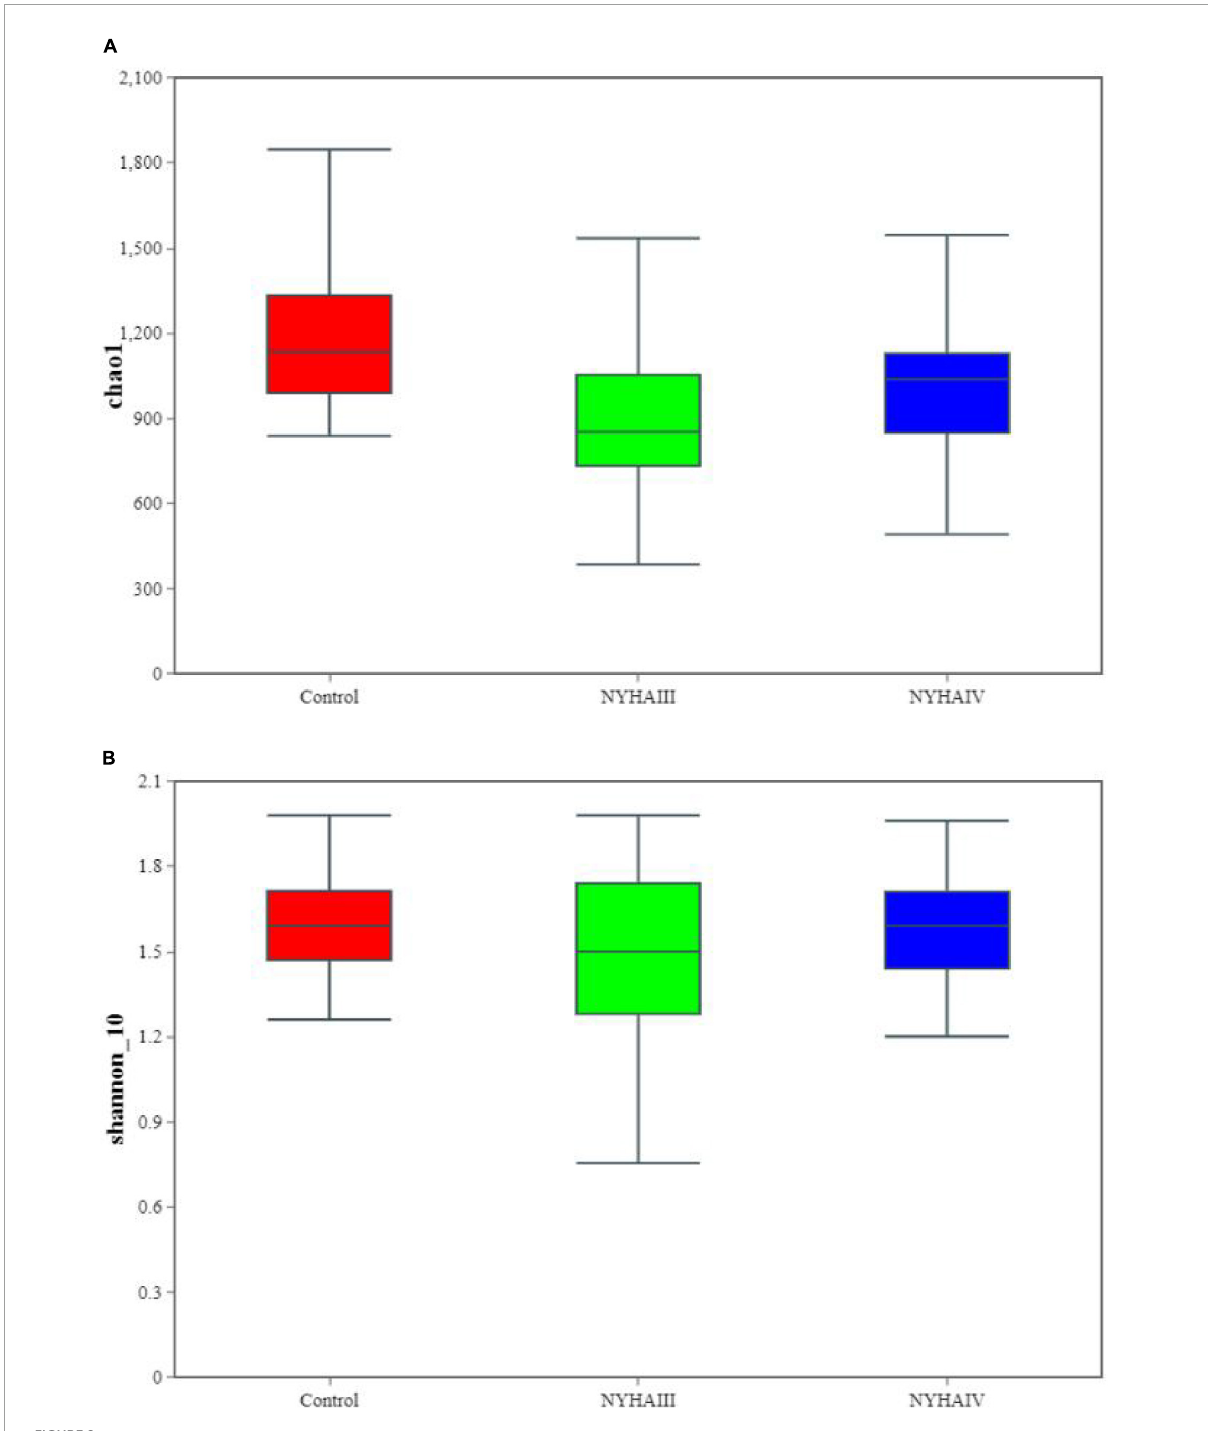
FIGURE2 The α -diversity index analysis between Control, New York Heart Association (NYHA) class III, and NYHA class IV(at the Operational Taxonomic Unit level). (A) Chao1 index. (B) Shannon index.